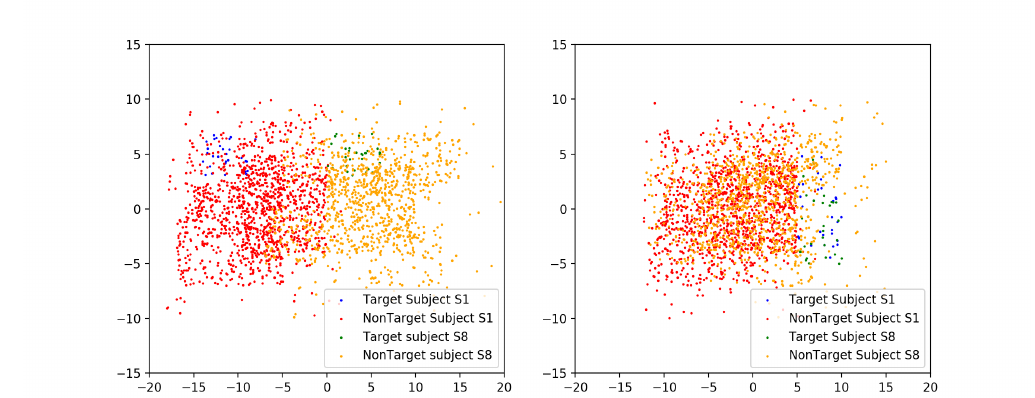
Figure 8. SPD covariance matrix of Subjects S1 and S8 before affine transformation of Dataset I ( left ); and SPD covariance matrix of Subjects S1 and S8 after affine transformation of Dataset I ( right ).